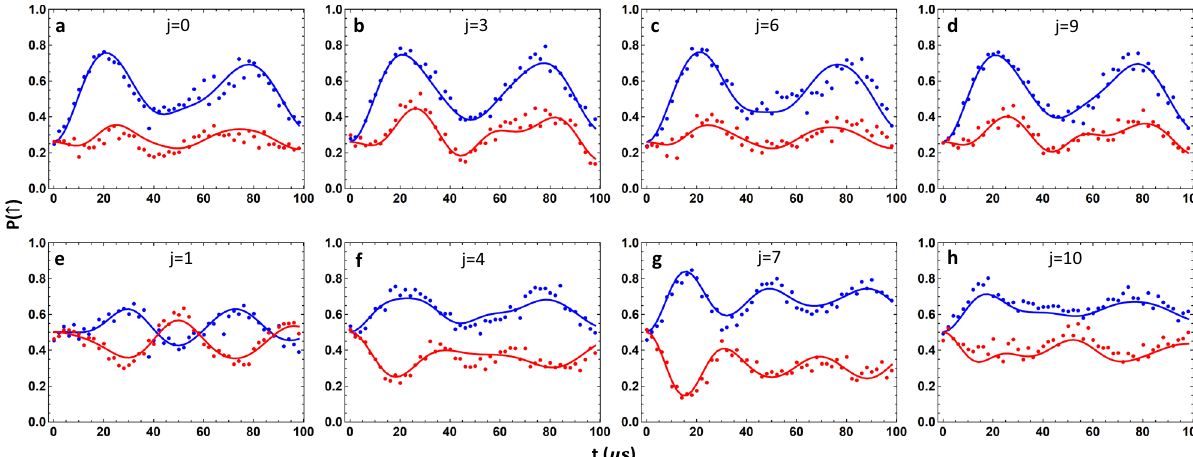
Fig. 4 Measuring ground state supercharges. We reconstruct the phonon density matrix with the spin projected to σ z = ±1 or σ y = ±1 by maximum- likelihood estimation. a – d The measured spin dynamics under blue-sideband (blue dots) and red-sideband (red dots) driving and those predicted by the best- fi tted density matrix (blue and red curves) for | ψ − 〉 after four typical phonon displacements with σ z projected to ±1. Each data point is the average of 400 experimental shots, half of which have a σ z gate before the measurement sequence to remove the off-diagonal spin terms. e – h Similar plots for | ψ − 〉 after four typical phonon displacements with σ y projected to ±1. Here, we choose ω = 2 π × 10 kHz and g m = 2 π × 5.43 kHz. The displacement operators ¼ i β e 2 π ij = N where β = 0.687, N = 12 and j = 0, 1, … , N − 1. The complete data for all the displacements and both | ψ − 〉 and | ψ + 〉 D ( β j ) are characterized by β j are presented in Supplementary Note 2. From the fi tted density matrices, we get 〈 σ z ⊗ A 〉 = 0.201 ± 0.013 and 〈 σ y ⊗ B 〉 = 0.300 ± 0.009 for | ψ − 〉 and 〈 σ z ⊗ A 〉 = − 0.163 ± 0.017 and 〈 σ y ⊗ B 〉 = − 0.349 ± 0.011 for | ψ + 〉 where error bars are estimated by Monte Carlo sampling (see